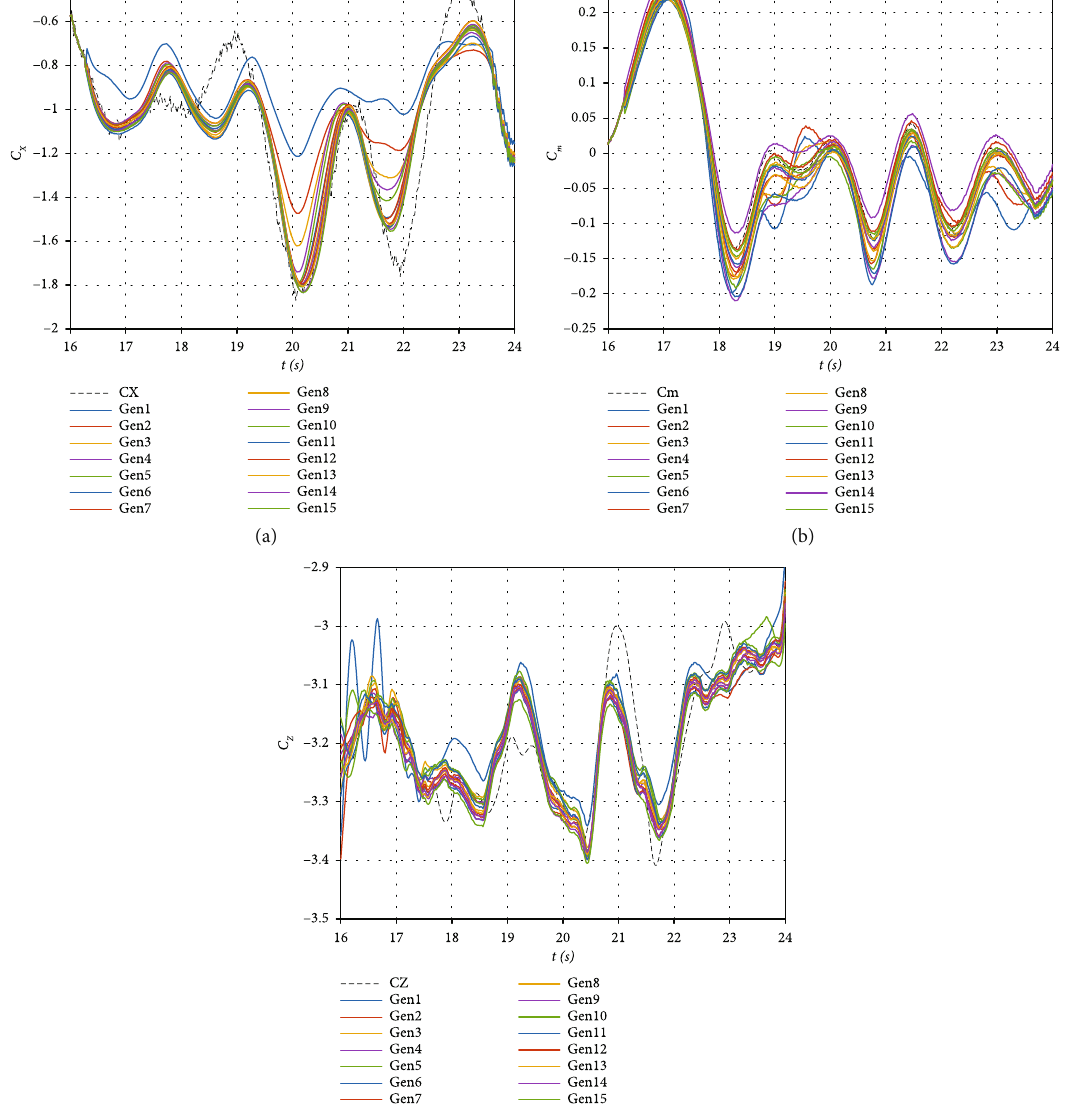
, (b) C , and (c) C X m